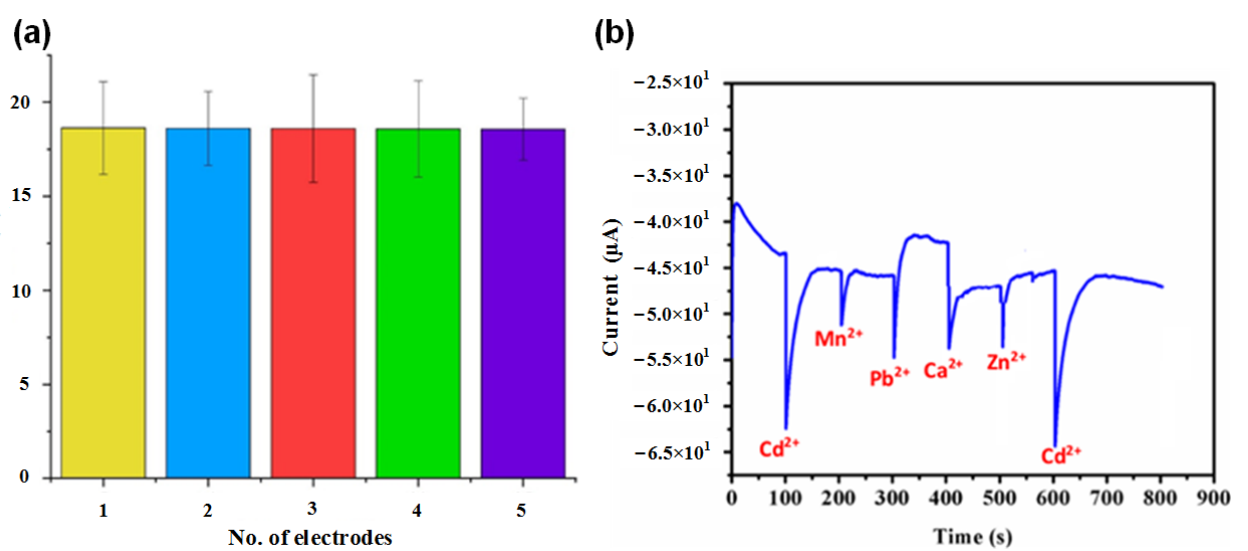
Figure 5. ( a ) The reproducibility test of PB-PEDOT/LSG/GCE-modified electrode for the detection of 500 µM Cd 2+ in 0.1 M acetate buffer, pH 5.00, by DPV using the potential of − 1.4/ − 0.6. The standard deviations are obtained from 3 measurements ( n = 3); ( b ) amperometric responses of PB-PEDOT/LSG/GCE-modified electrodes upon successive addition of 500 µM Cd 2+ and 10-fold other common ions (Mn 2+ , Pb 2+ , Ca 2+ and Zn 2+ ).